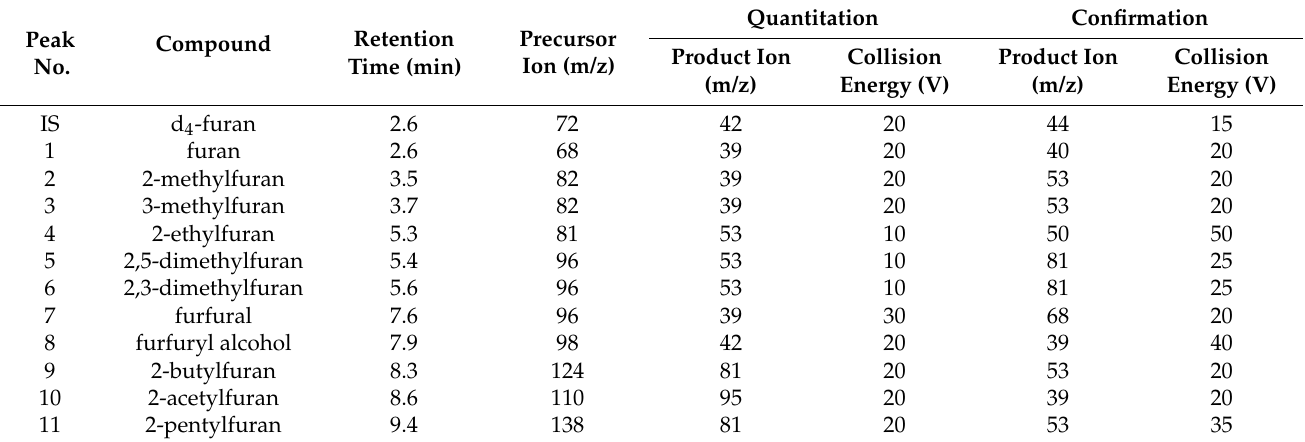
Table 1. Operation parameters of furan and its 10 derivative standards, and one internal standard (IS) in multiple reaction monitoring mode by GC-MS/MS.